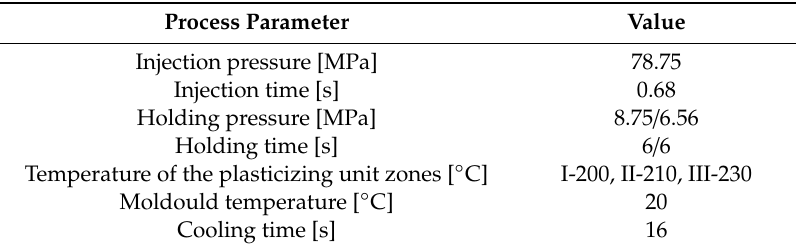
Table 1. Injection molding parameters used to prepare samples.